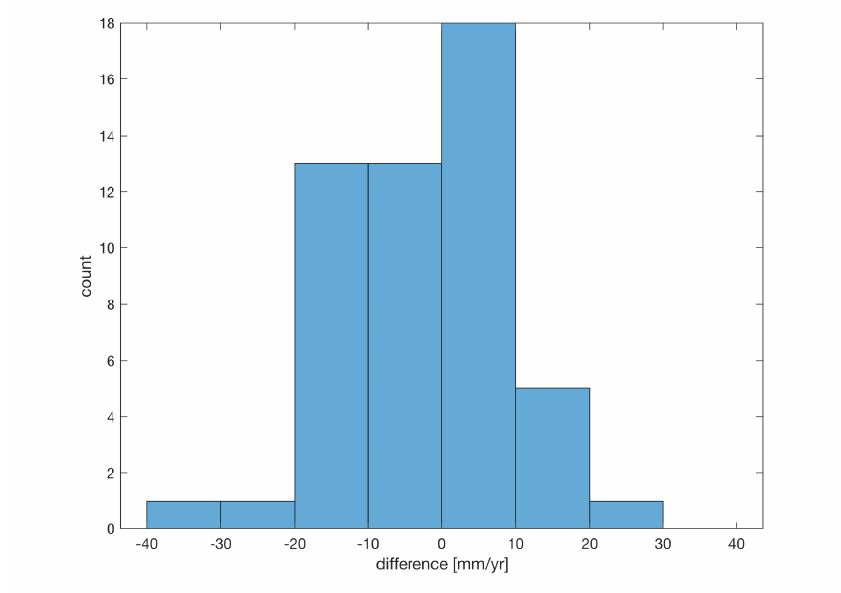
Figure 7. Histogram of differences between range change rate at COSO with respect to COSJ estimated from GPS using linear interpolation and extrapolation and range change rates at COSO with respect to COSJ observed by Envisat